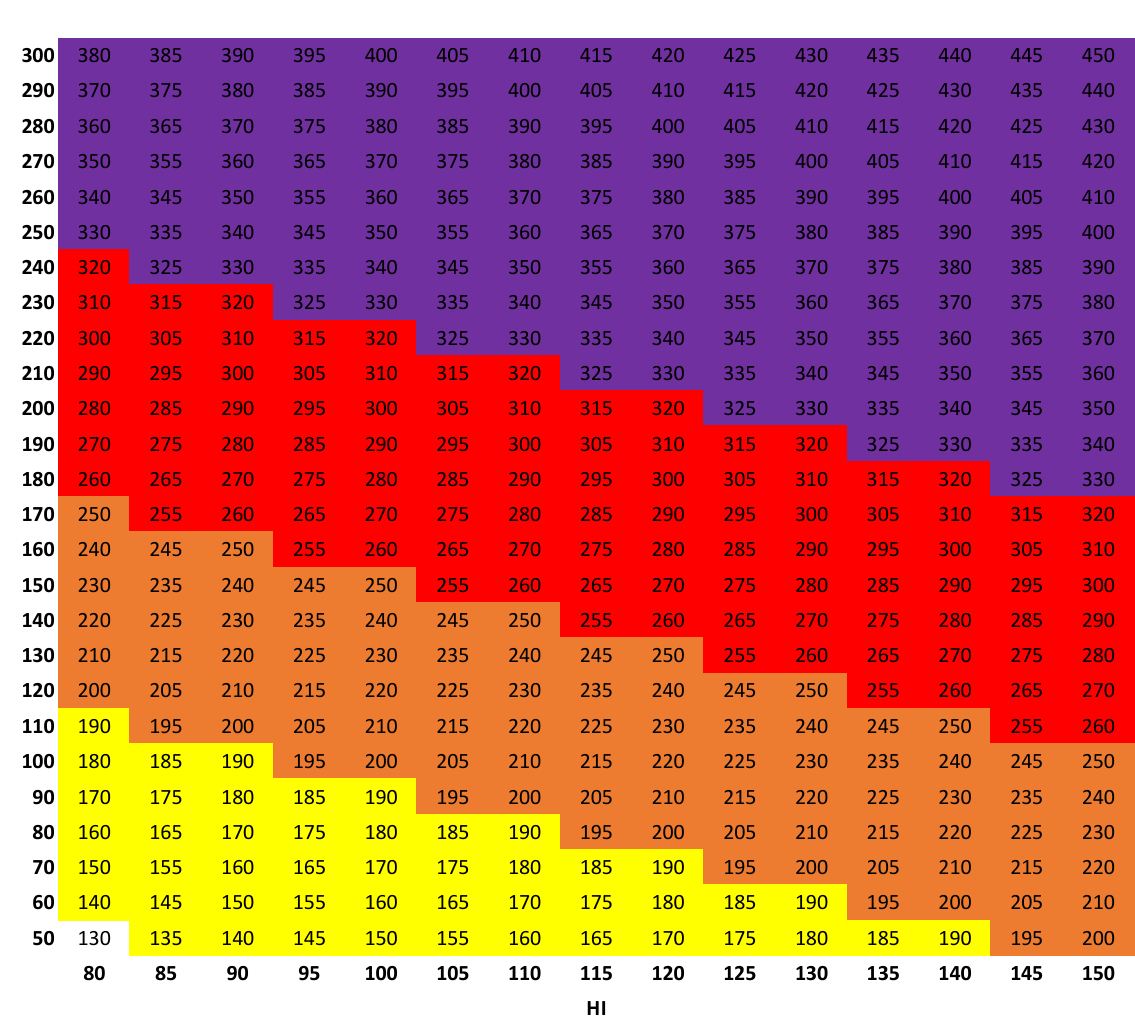
Figure 6. Chart depicting the combined air quality and heat index SUM-HI (index details are described in Table 1).